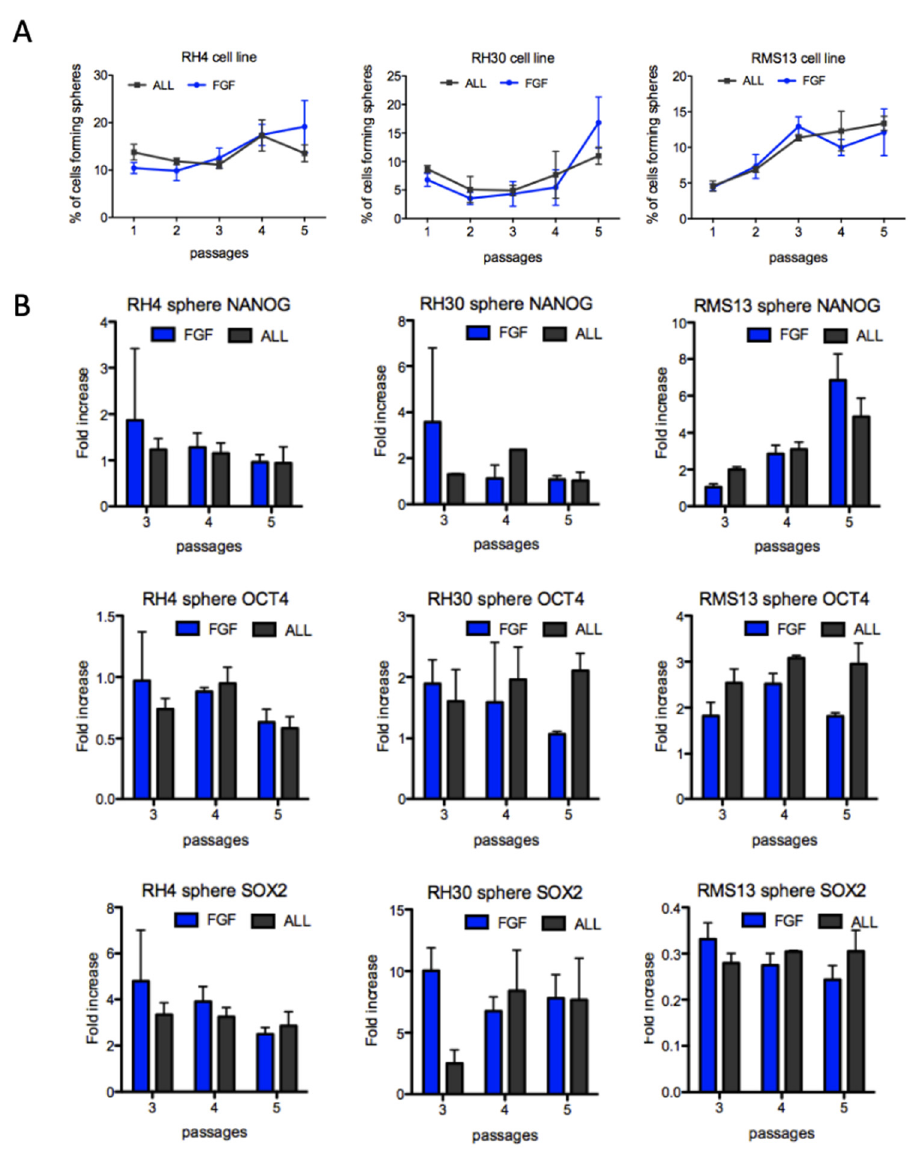
Figure 1. No enrichment of cancer stem-like cells in FPRMS spheres. ( A ) Sphere assay with RH4, RH30, and RMS13 cells cultivated in sphere medium supplemented with bFGF (FGF) or with bFGF, EGF, and PDGF (ALL) over indicated number of passages. Percentage of cells forming spheres was calculated at each passage. Represented are means of triplicates ( n = 3). ( B ) Quantification of mRNA expression by real-time PCR of NANOG, OCT4, and SOX2 in spheres of three FPRMS cell lines at passage 3, 4, and 5. Fold increases are calculated compared to the cells cultured as a monolayer. Represented are means of triplicates ( n =